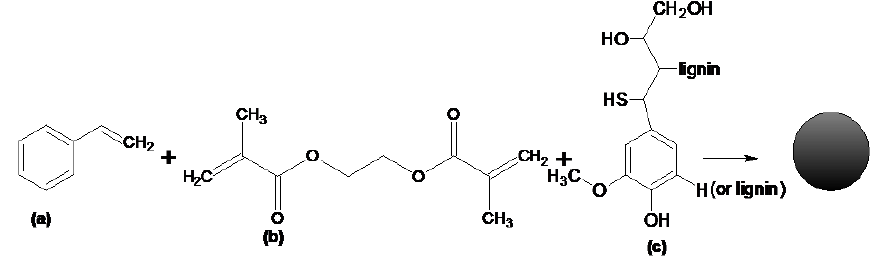
Figure 1. Chemical structure of monomers. ( a ) styrene, ( b ) ethylene glycol dimethacrylate, ( c ) lignin.